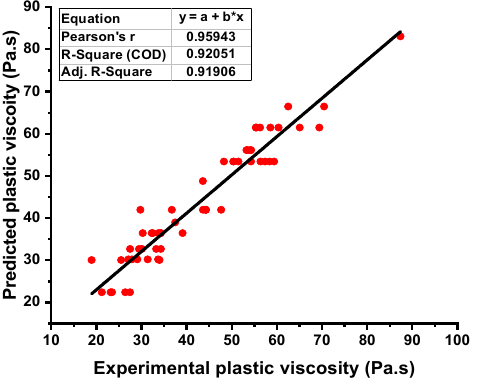
Figure 9. Plastic viscosity relationship for the actual and predicted result of R-F model.